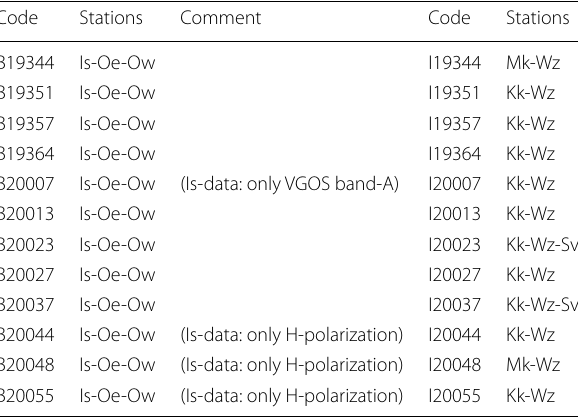
Table 1 VGOS-B sessions in December 2019 through February 2020, and their simultaneously observed INT1